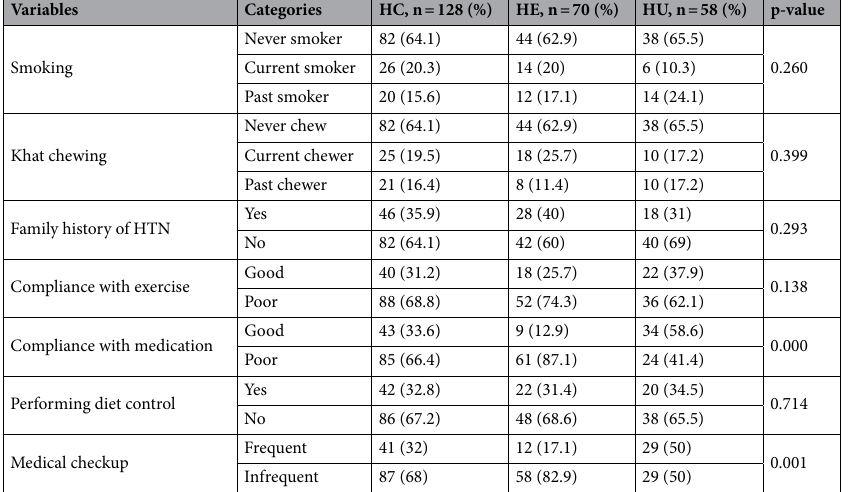
Table 2. Risk factors for patients with hypertensive